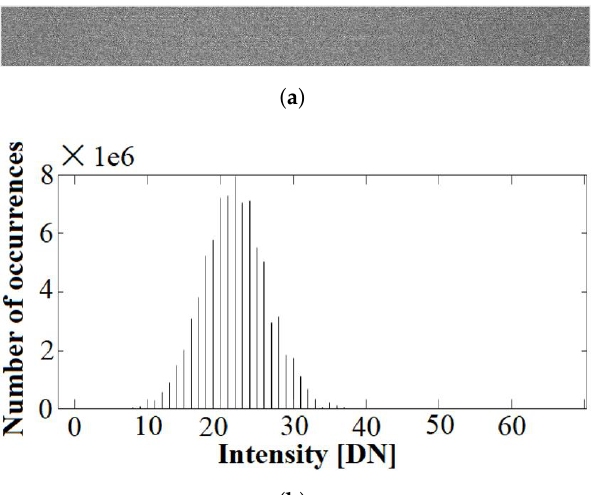
Figure 4. Example DR image for background noise calibration: ( a ) Band number 319 (which corre- sponds to 631 nm). ( b ) Histogram of the noise intensity when shutter is